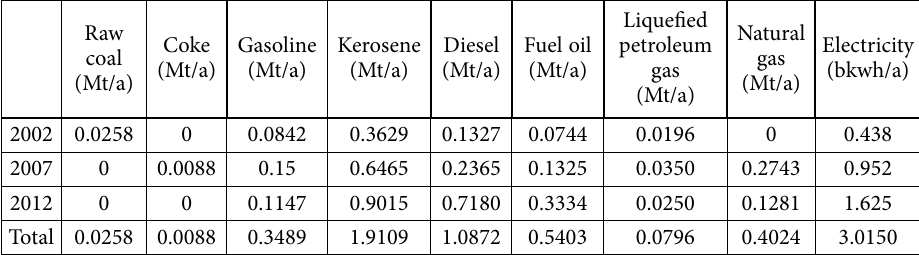
Table 4. The amount of energy consumption of tourism in